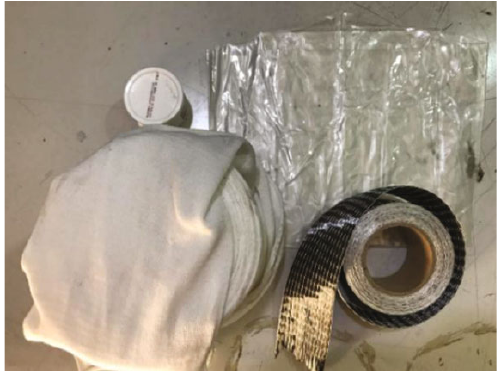
Figure 2: Prosthetic and orthotic